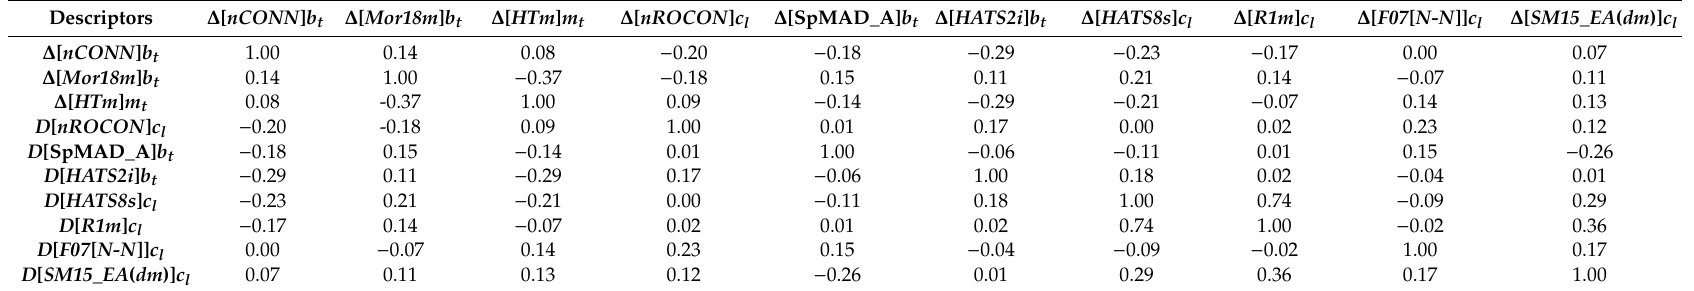
Table 2. Degree of collinearity among the variables of the mt-QSAR LDA